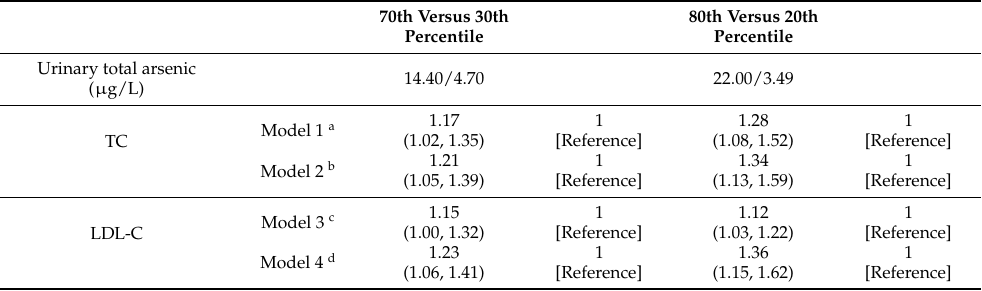
80th Versus 20th Percentile